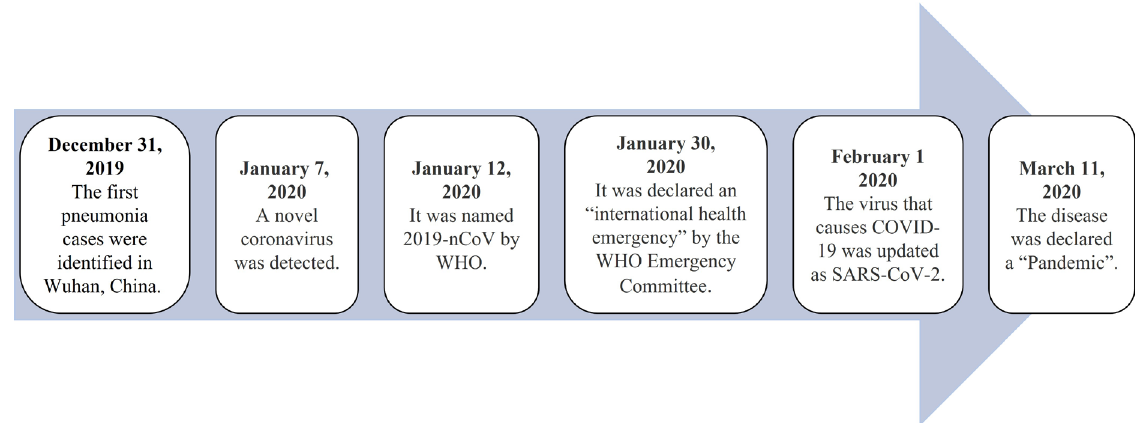
Figure 1. COVID-19 pandemic